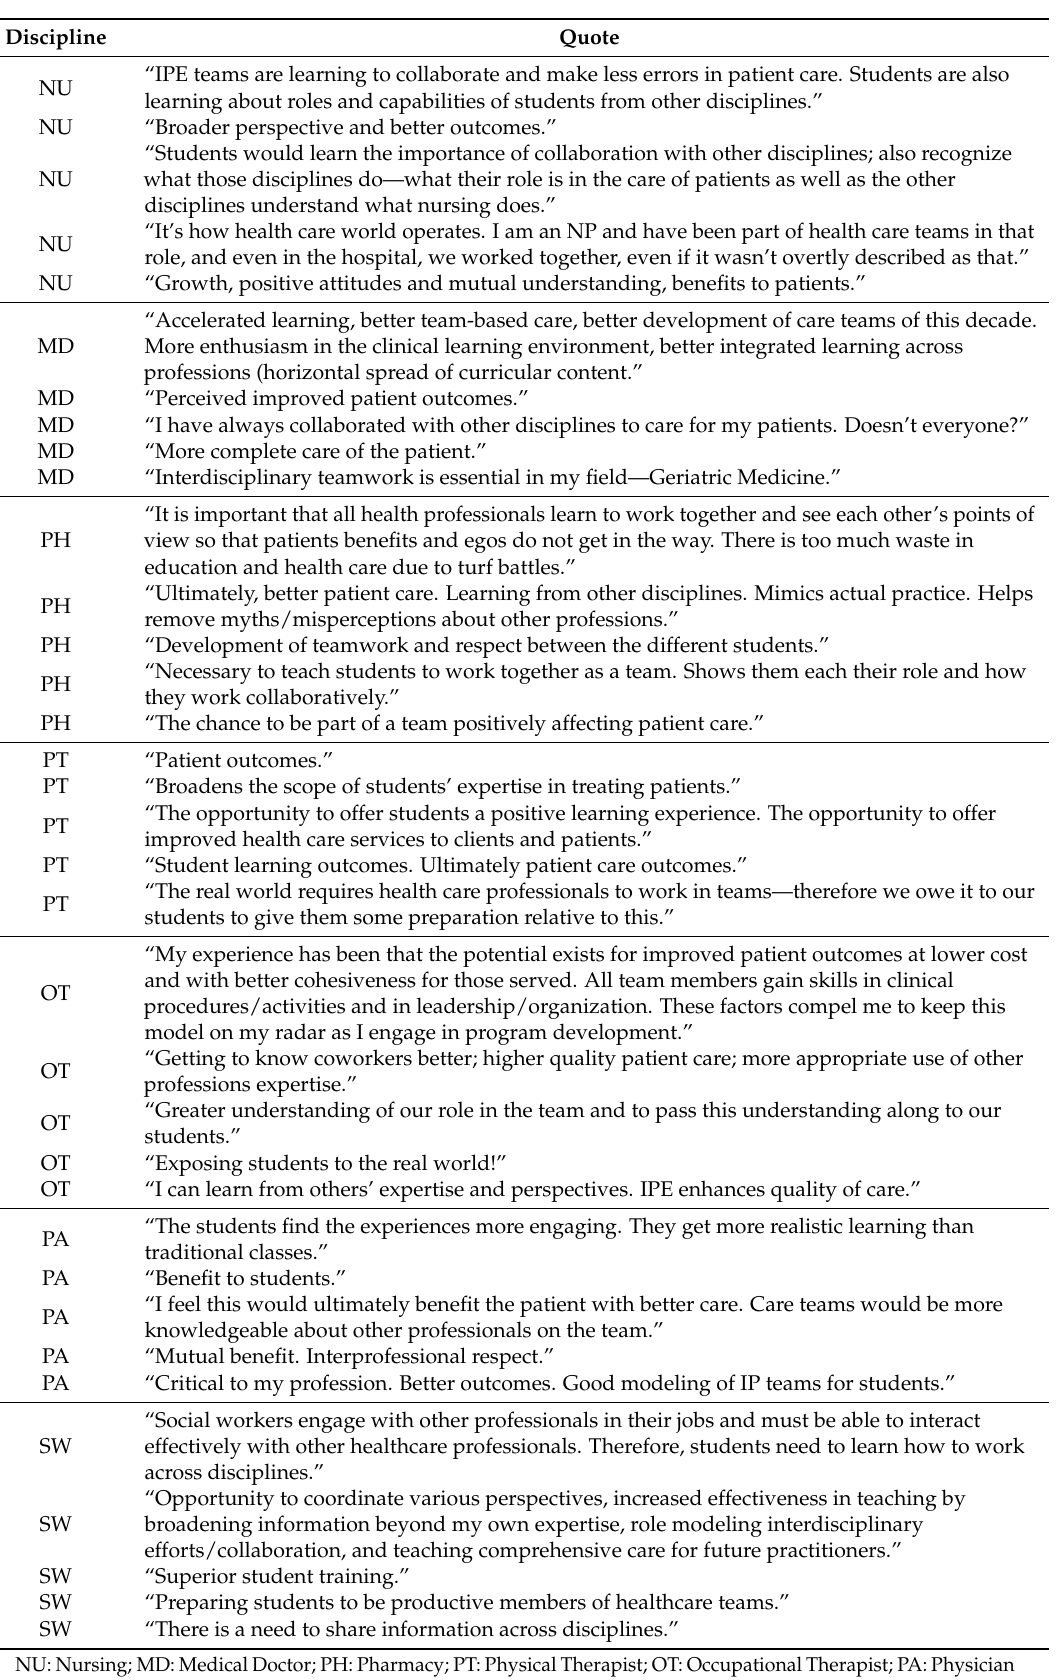
Table 3. Quotes that support positive